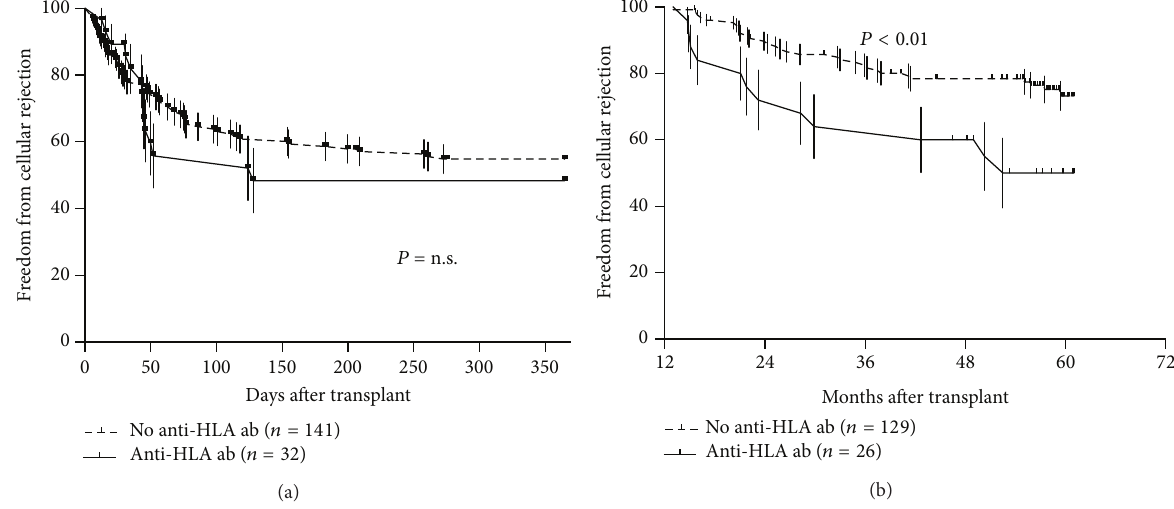
Figure 3: Kaplan-Meier estimate of freedom from cellular rejection. (a) Survival free from cellular rejection graded ≥ 3A/2R on surveillance endomyocardial biopsies performed during year 1 in patients with or without pretransplant HLA ab. (b) Survival free from cellular rejection graded ≥ 3A/2R on surveillance endomyocardial biopsies performed after year 1 in patients with or without pretransplant HLA ab. in EMB performed 62 ± 27 months after transplant.